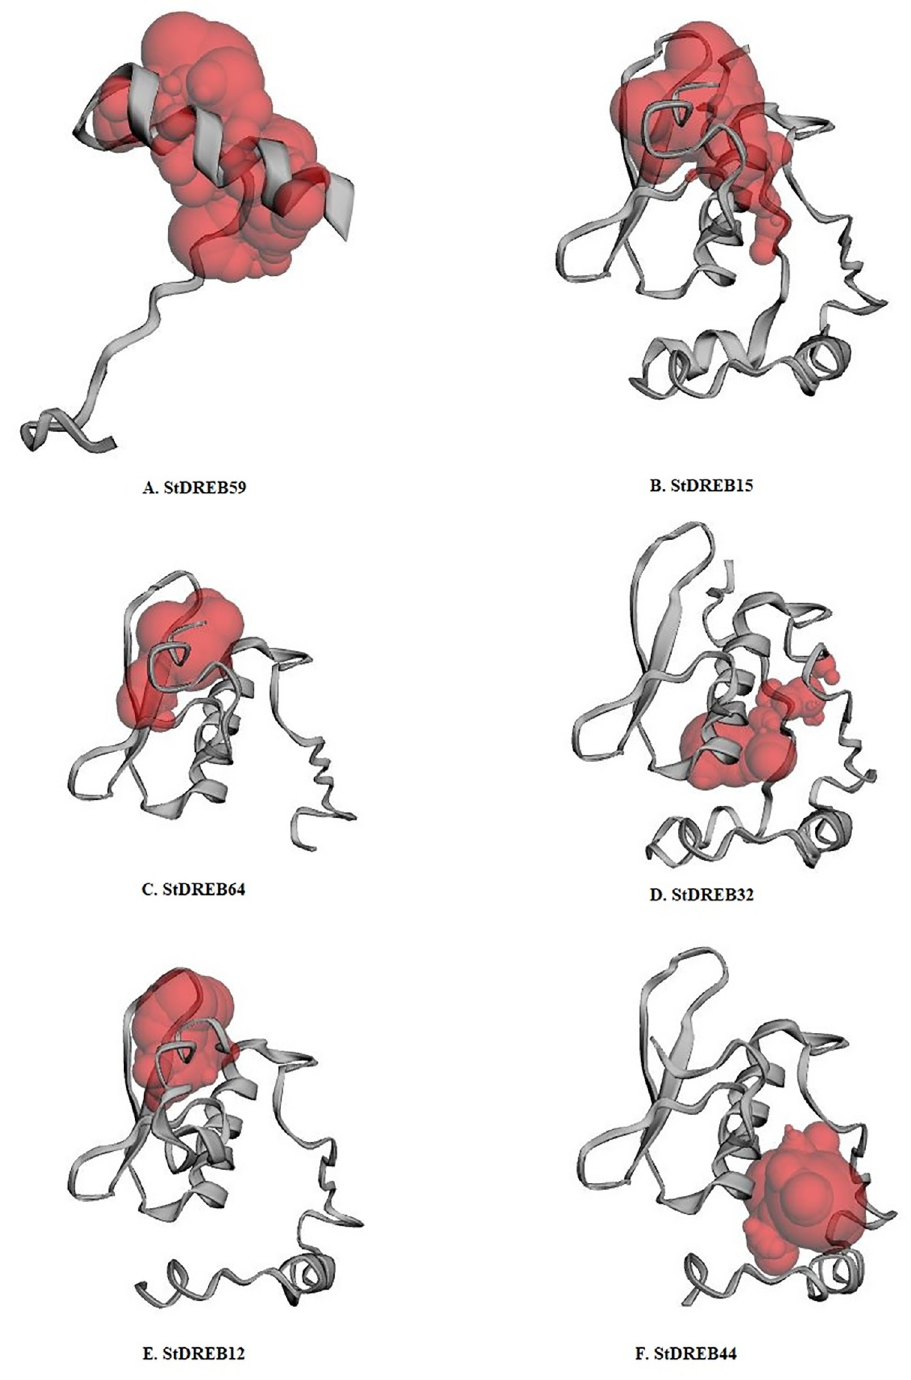
Fig 9. Predicted 3D structures and pocket binding sites of the StDREB proteins. The putative 3D structures of StDREB proteins were generated by the Phyre2 server and refined by the Galaxy Refine server. The active catalytic binding sites were illustrated as red regions using the CASTp server